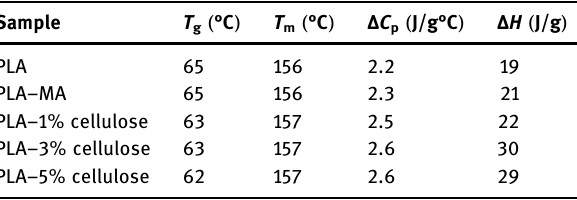
Table 2: Glass transition temperature ( T g ) , melting temperature ( T ) , speci fi c heat ( Δ C ) , and enthalpy ( Δ H ) for each m p